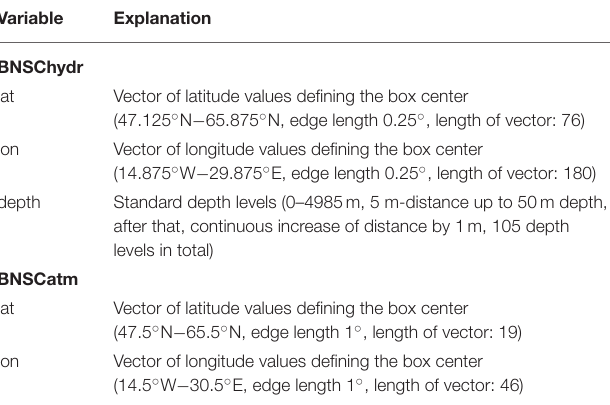
TABLE 4 | Dimensions of the BNSChydr and BNSCatm data